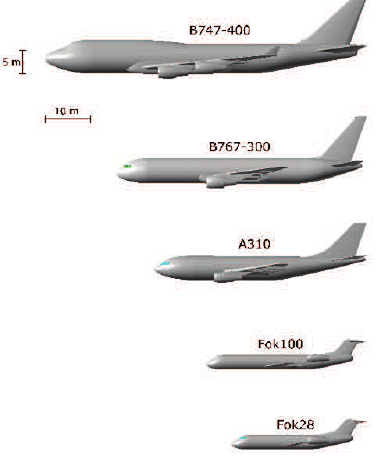
Figure 2. CAD models used for the RCS